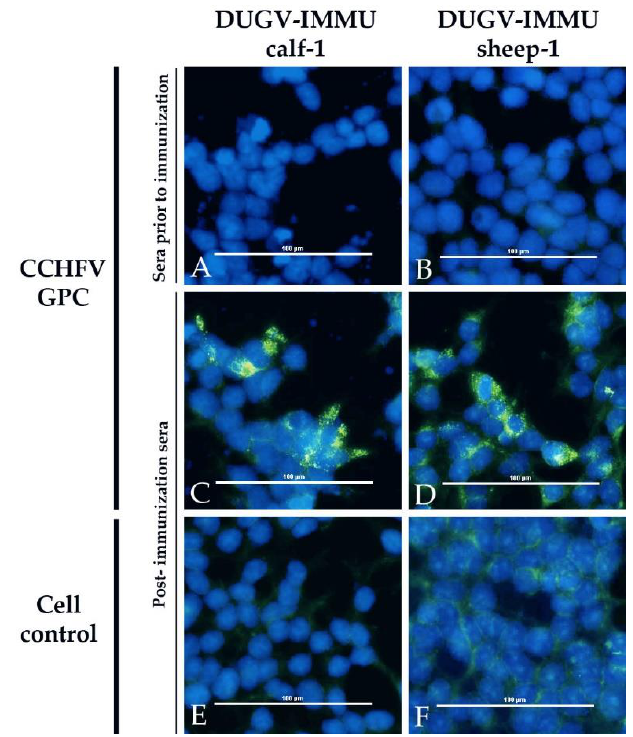
Figure 7. CCHFV immunofluorescence assay with DUGV hyperimmune sera: Cells expressing CCHFV GPC ( A – D ) and non-transfected controls ( E + F ) are depicted. The post-immunization serum of the immunized calf (DUGV-IMMU-calf-1) was diluted 1/300 ( A + C + E ) and the serum of the immunized sheep (DUGV-IMMU-sheep-1) was diluted 1/20 ( B + D + F ). Sera prior to infection ( A + B ) did not lead to a positive signal on cells transfected with CCHFV GPC, but post-immunization sera were clearly positive ( C + D ).